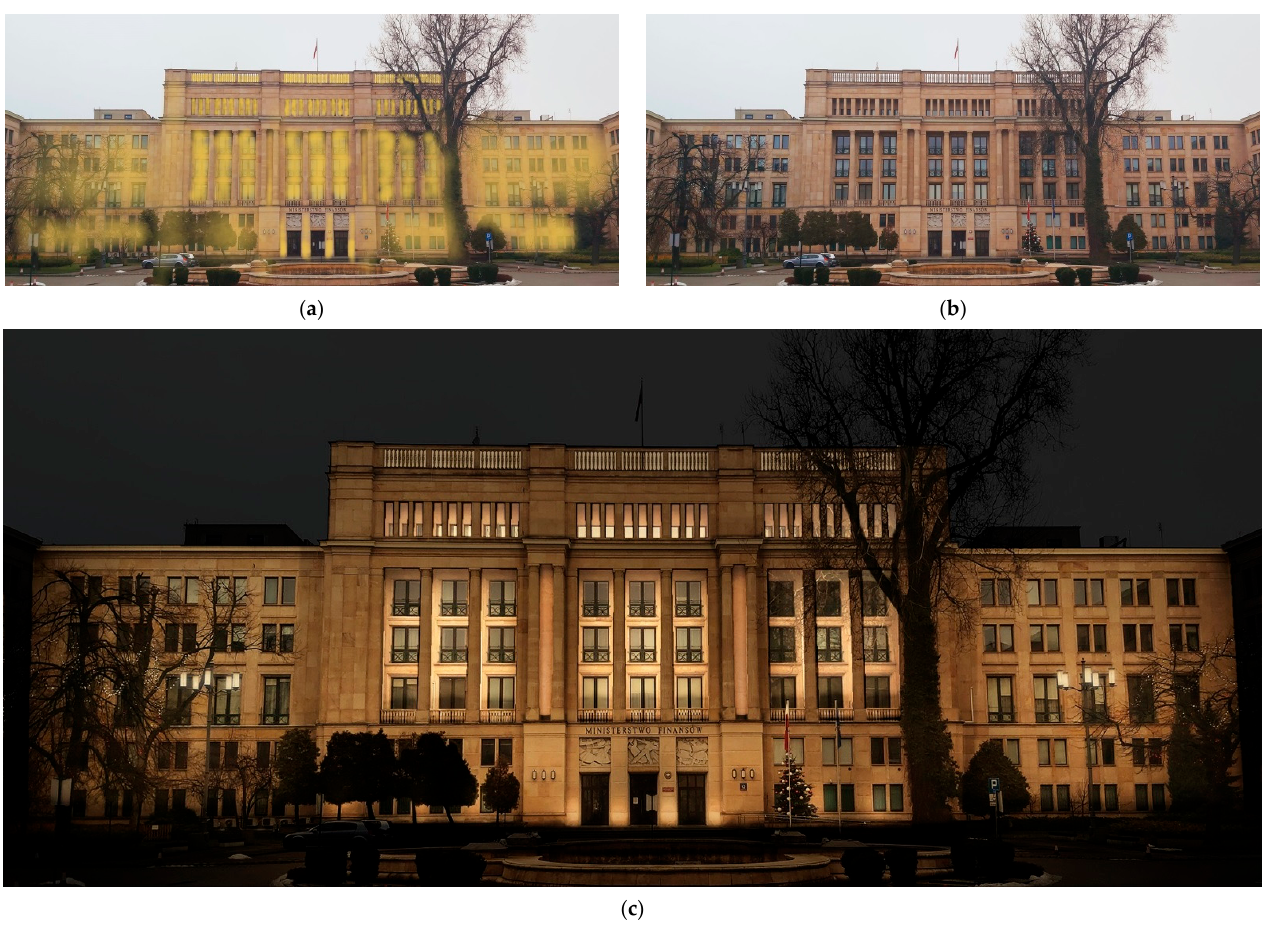
Figure 1. Visualisation of the object illumination. ( a ) The 2D floodlighting concept based on ( b ) the daytime photo, and ( c ) the 2.5 D simulation of the floodlighting created on the basis of the same daytime photo.